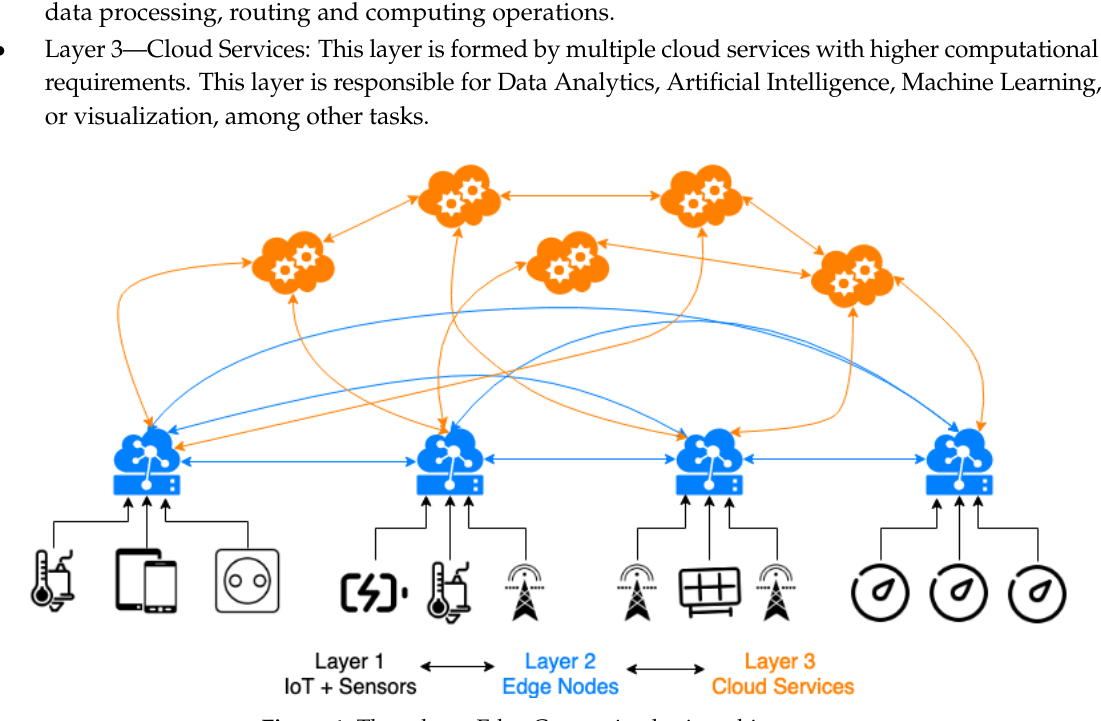
Figure 1. Three-layer Edge Computing basic